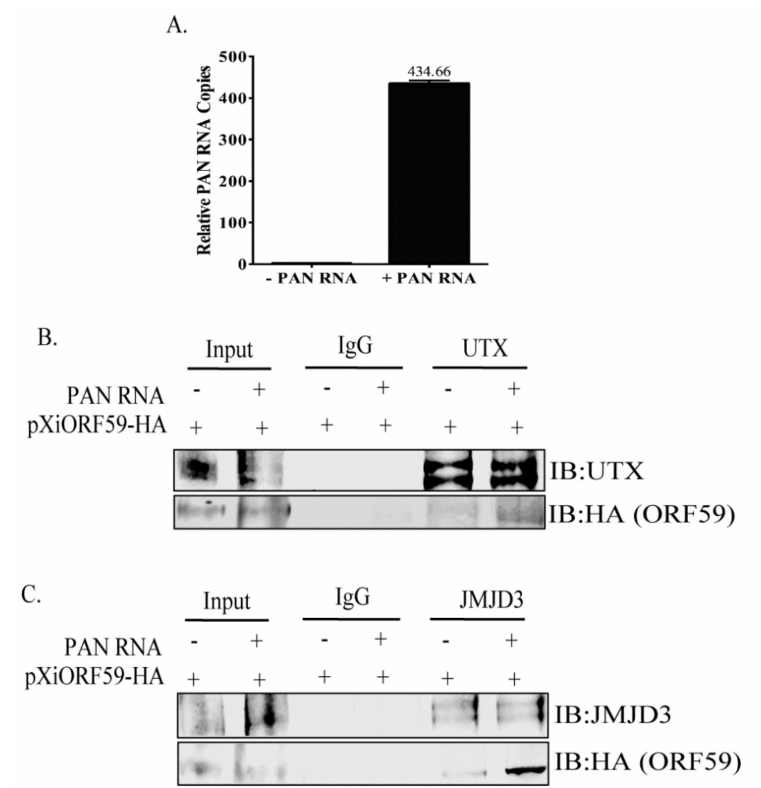
Figure 3. PAN RNA expression enhances ORF59 (cid:48) s interaction with UTX or JMJD3. ( A ) Total RNAs extracted from HEK293 cells transfected with or without PAN RNA and the expression vectors were subjected to RT-qPCR to determine the level of PAN RNA transcripts. Co-IPs were performed on HEK293 cells transfected with or without PAN RNA and the specific expression vectors. ( B ) IP with anti-UTX antibody showed ORF59 co-precipitated in the presence of PAN RNA only (lane 6). ( C ) IP with anti-JMJD3 antibody displayed more ORF59 binding activity in the presence of PAN RNA (lane 6) than in the absence of PAN RNA (lane 5). Control IgG antibody was used as a